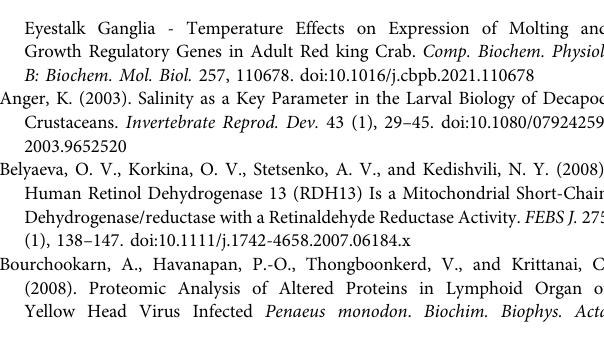
Supplementary Figure S1 | Expression levels of 9 larval samples. (A) Boxplots of the 9 transcripts based on fragments per kilobase of transcript per million mapped fragments (FPKM). (B) Heatmap plot showing the correlation of gene expression levels among the samples. Supplementary Figure S2 | Transcription factor family classi fi cation for the 1535 DEGs from the complete transcriptome. Supplementary Figure S3 | The proportion of different motifs across all